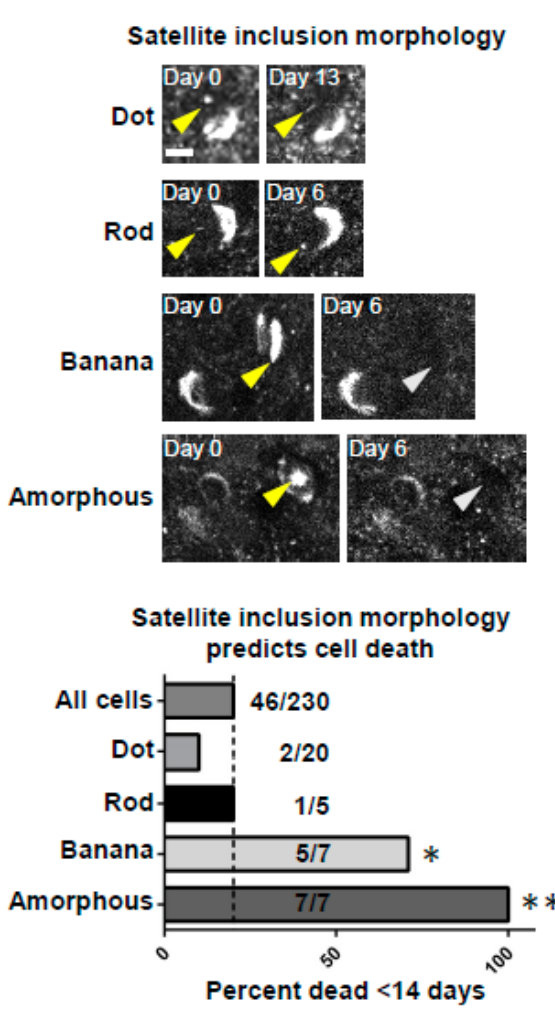
Figure 5. Development of specific intranuclear aggregate morphologies predicts imminent cell death. Top : Examples of specific intranuclear aggregate morphologies (dot, rod, banana, and amorphous). Scale bar: 5 µ m. Bottom : Group data showing predictive value for the development of intranuclear inclusions with different morphologies in predicting cell death within the next 14 days compared to the frequency expected from “all cells”, which includes those with and without intranuclear inclusions (dotted line). The first value to the right of each column represents the number of cells that died within 14 days in that category, and the second number represents the total number of cells detected in that category. The probability of observing this number of cell death events by chance using the binomial distribution predicted p -values * < 0.005 for “banana” and ** <0.0001 for “amorphous”